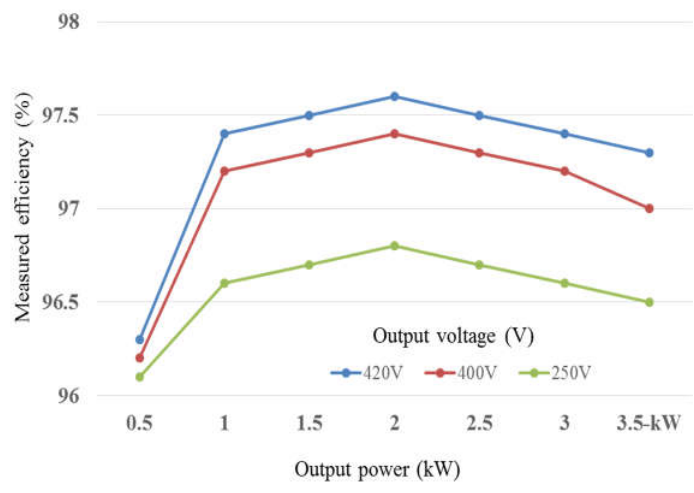
Figure 13. Efficiency curves of the proposed converter.